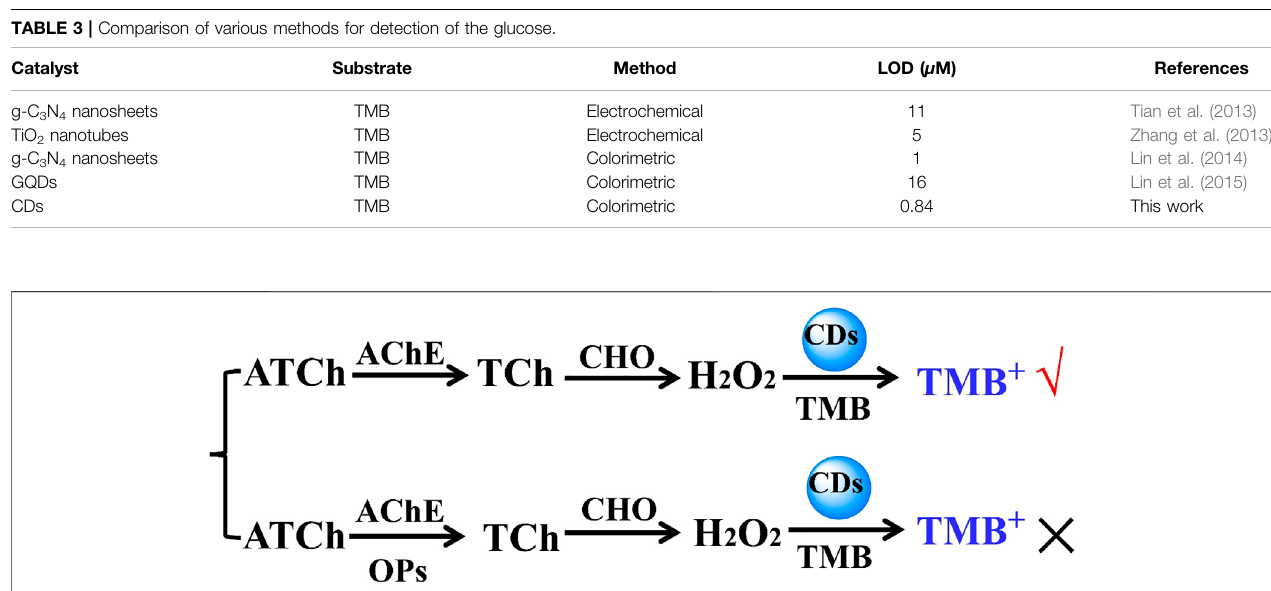
Frontiers in Chemistry |